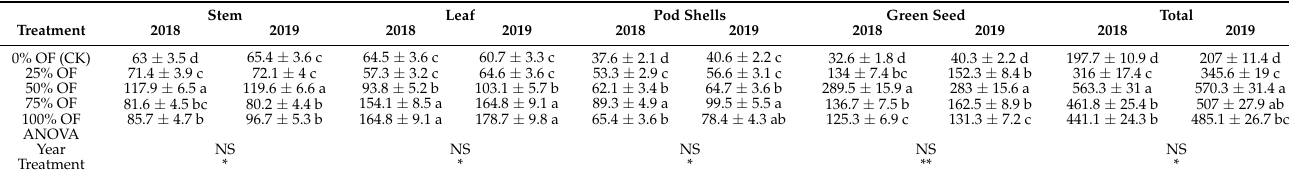
Table 7. The nitrogen accumulation at harvest of green seeds for different treatments (kg ha − 1 ).